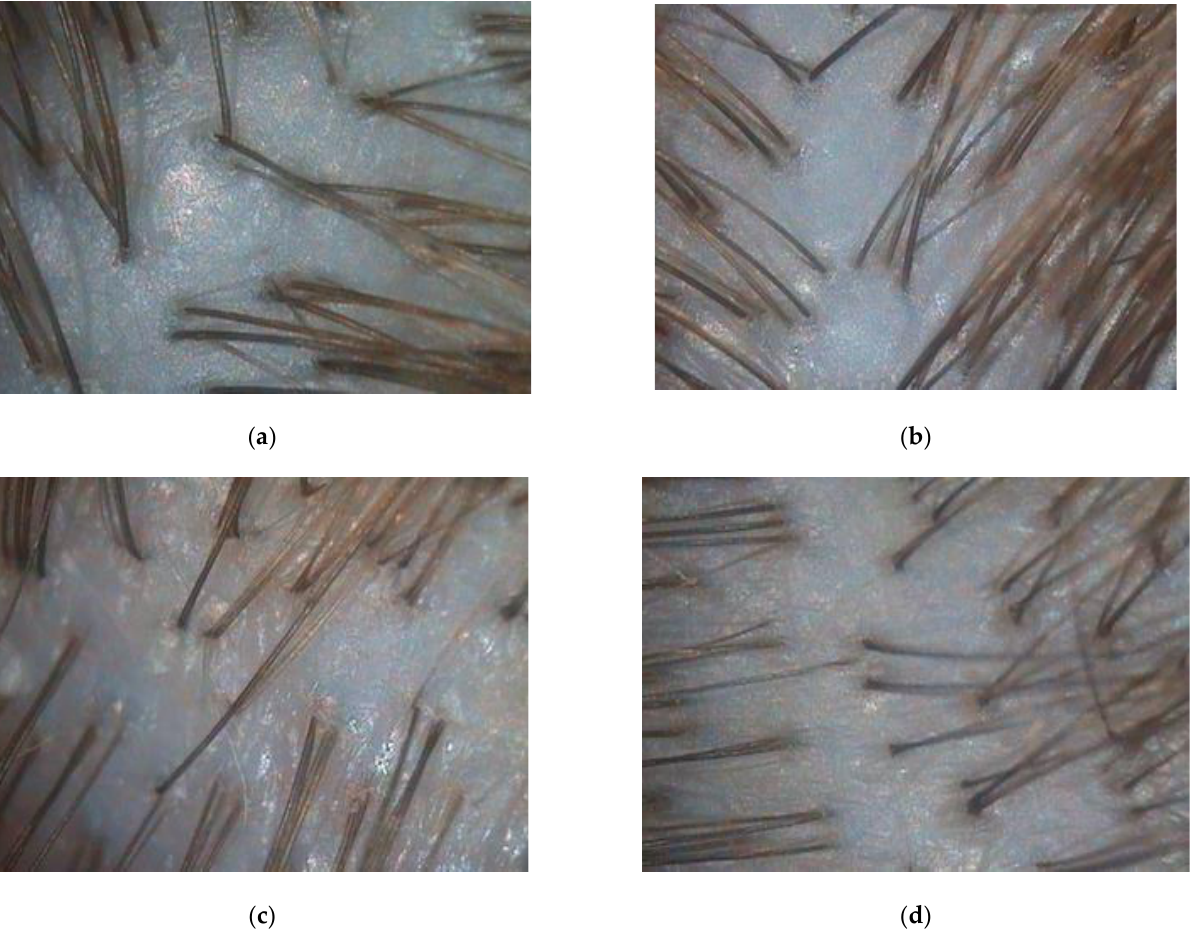
Figure A3. Microphotographs of hair density before and after the trial in the patient I-va of the caffeine control Group 3. ( a ) Hair density on the frontal area before the trial; ( b ) hair density on the frontal area after the trial; ( c ) hair density on the occipital area before the trial; ( d ) hair density on the occipital area after the trial.